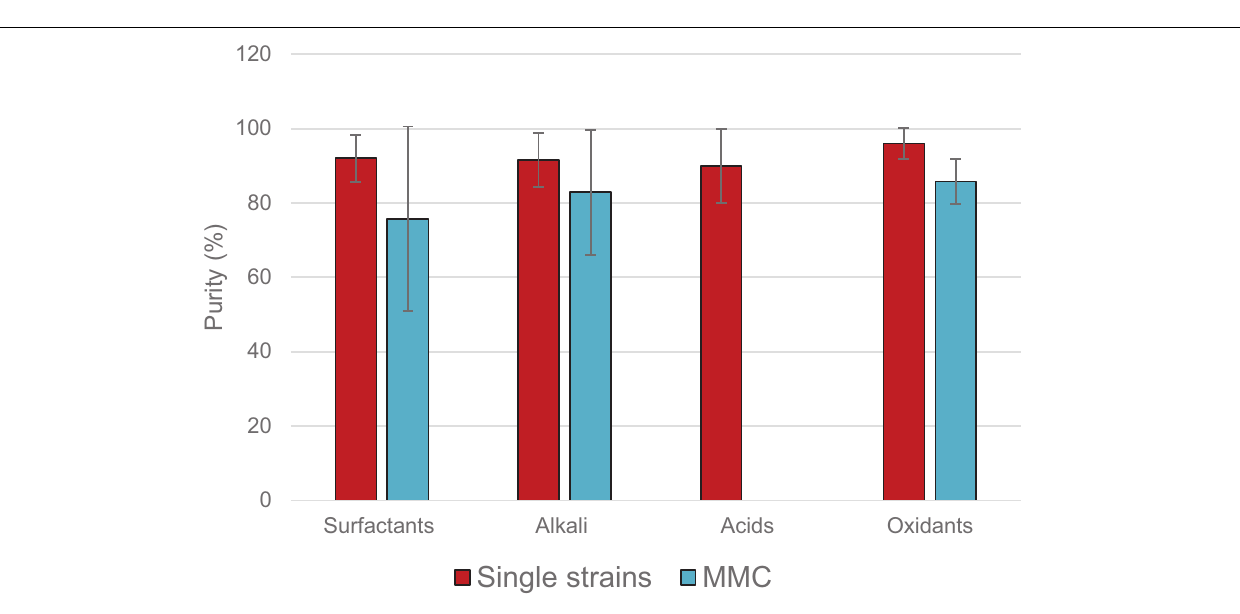
FIGURE 8 | Mean PHA purity (%) achieved through extraction with solvents (halogenated solvents, alcohols, ketones, and carbonates) from single strains or MMC.